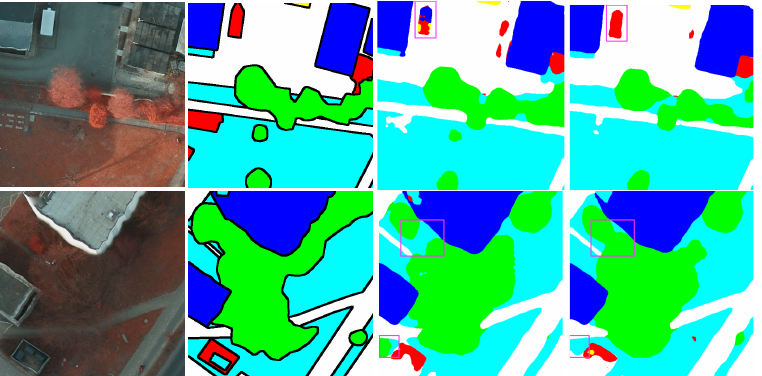
Figure 3. Visualization of the effect of dis . feat. The first two columns are input images and corresponding ground truth. The last two columns are the performance without and with dis .